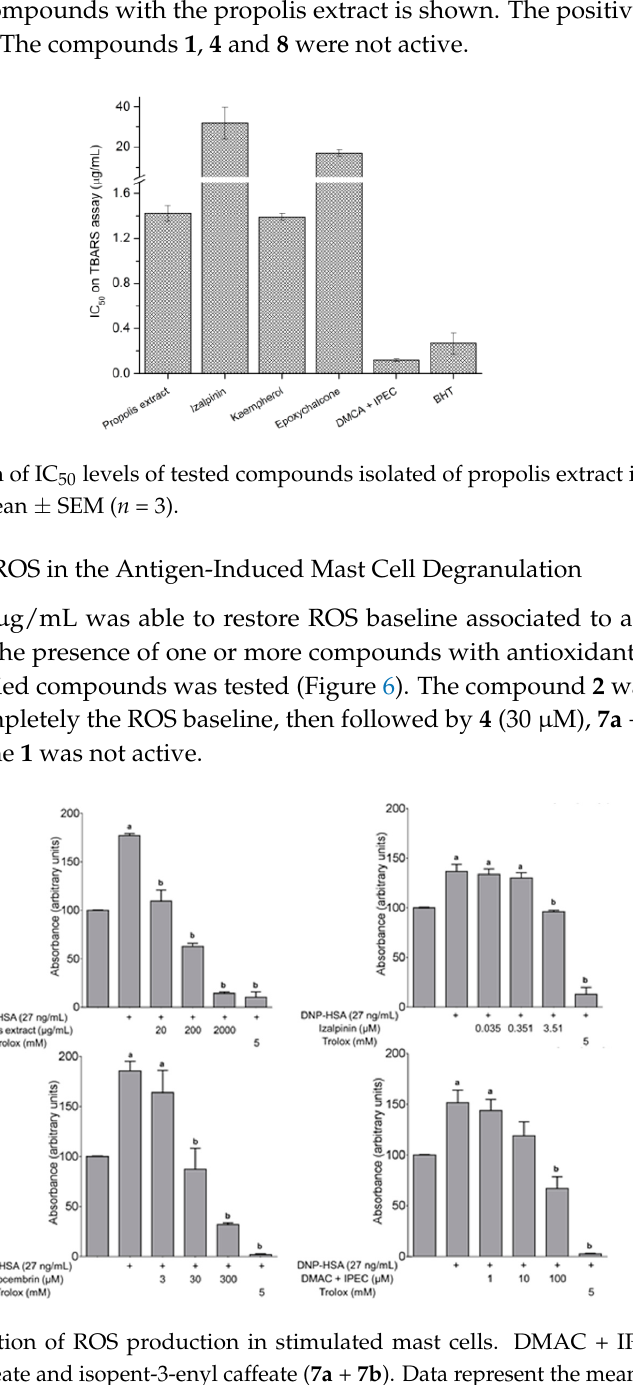
Figure 4. Chromatogram of propolis extract (5 mg/mL, 20 μ L injection) at 236 nm. ( 1 ) ( λ max 289 nm), ( 2 ) ( λ max 266.6 nm), ( 3 ) ( λ max 277.2 nm), ( 4 ) ( λ max 290.2 nm), ( 5 ) ( λ max 266.6 nm), ( 6 ) ( λ max 291.4 nm), ( 7 ) ( λ max 327 nm), ( 8 ) ( λ max 322.2 nm), ( 9 ) ( λ max 323.4 nm), ( 10 ) ( λ max 236 nm), ( 11 ) ( λ max 324.6 nm).